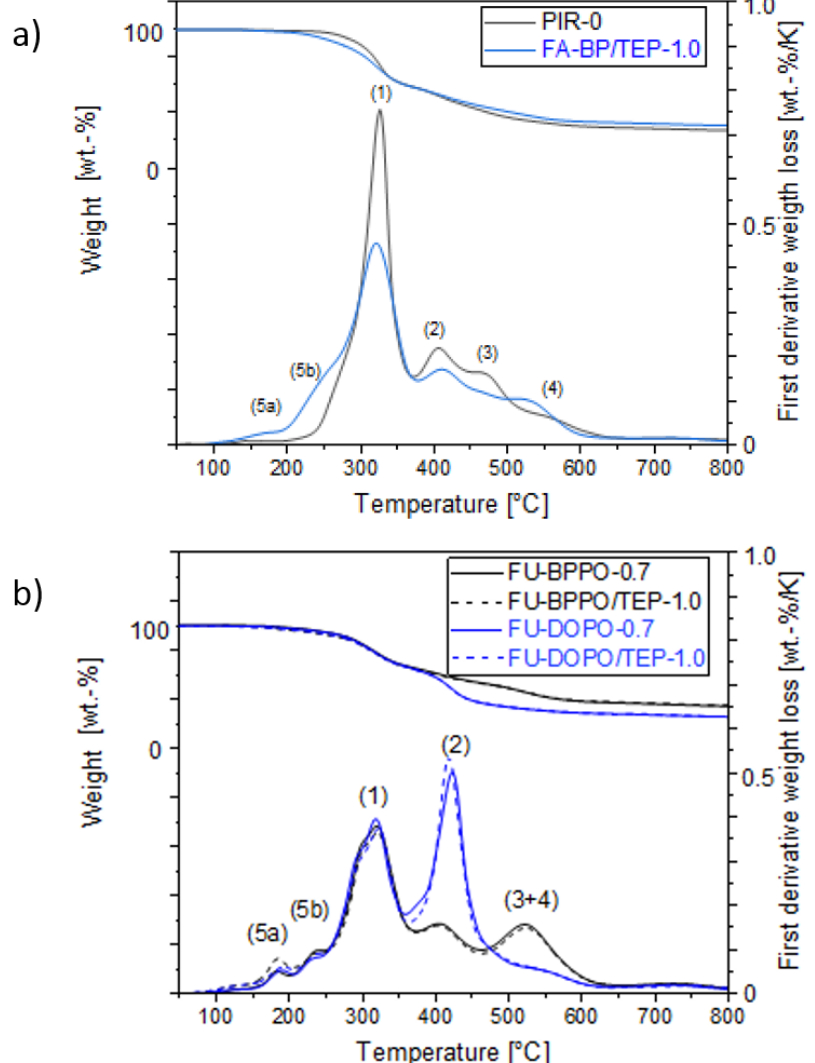
Figure 3. Thermogravimetric curves of selected PIR foams with phosphorus-containing FRs with different chemical structure. DOPO-containing foams can easily be identified by maximum (2) occurring in the first derivative curves (lower curves): ( a ) PIR-0 compared to a nonreactive FR and ( b ) comparison of different NCO-reactive FU-derivatives.